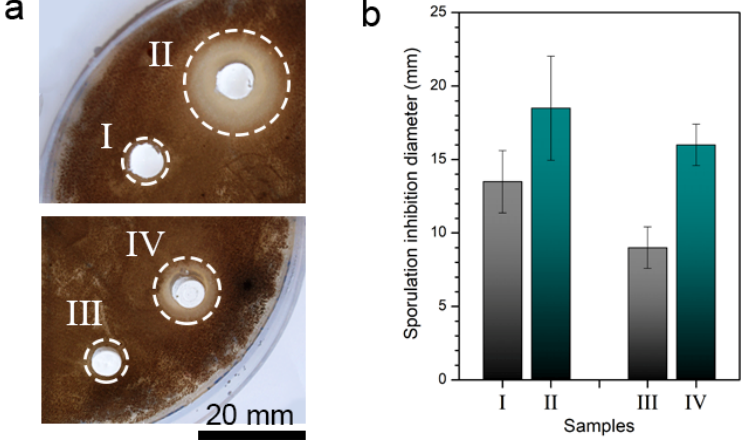
Figure 4. Antifungal activity test of waterborne paint with 0.5% of ZnO / Clay composite. ( a ) Bauer-Kirby disk di ff usion assay of fresh paint (I), fresh paint with ZnO / Clay (II), dry paint (III) and dry paint with ZnO / Clay (IV). Panel ( b ) shows sporulation inhibition diameter data of (I) fresh paint, (II) fresh paint with ZnO / Clay, (III) dry paint and (IV) dry paint with ZnO / Clay. The mean and standard deviation (s.d.) from the three experiments is shown.